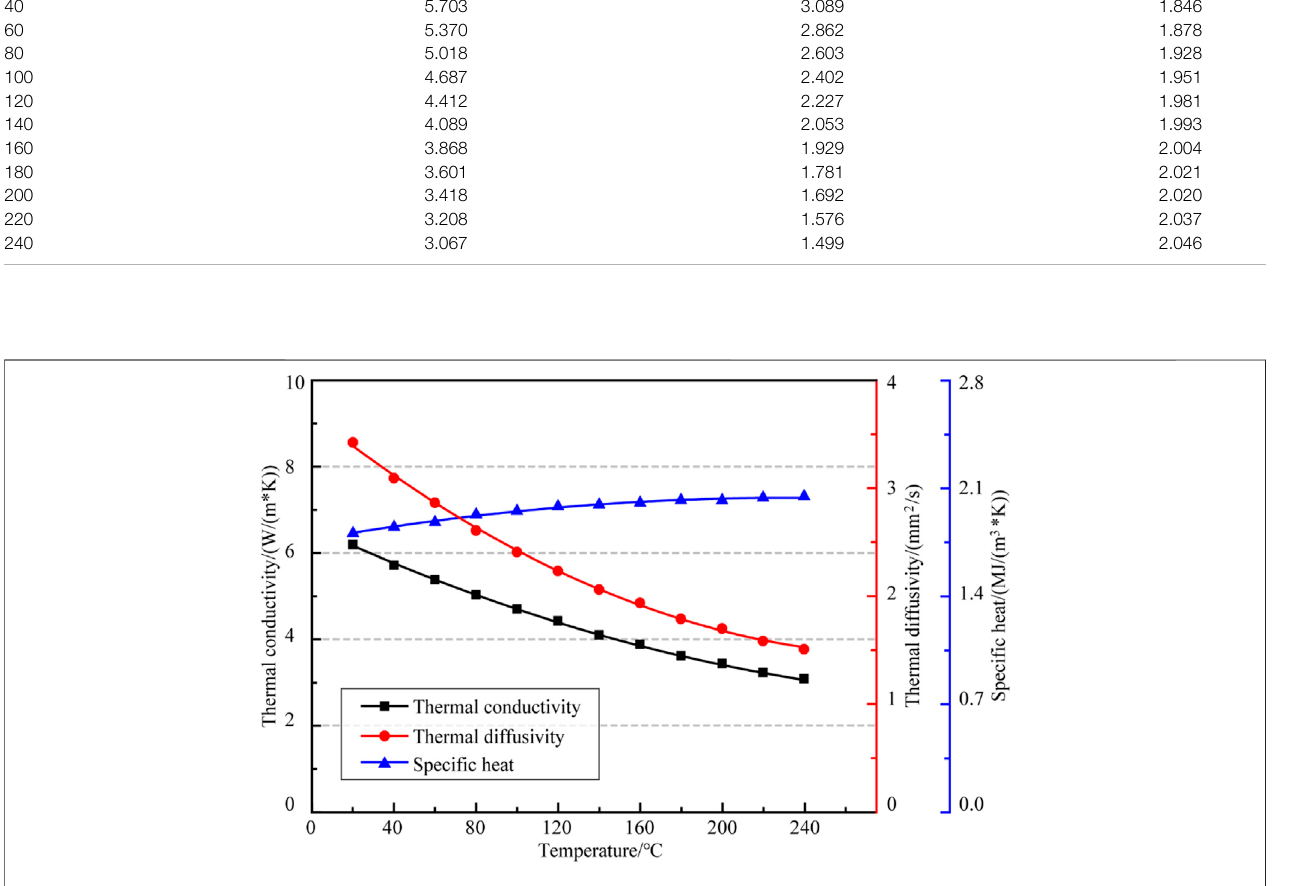
FIGURE 4 | Test results of thermal parameters of NaCl single crystal.